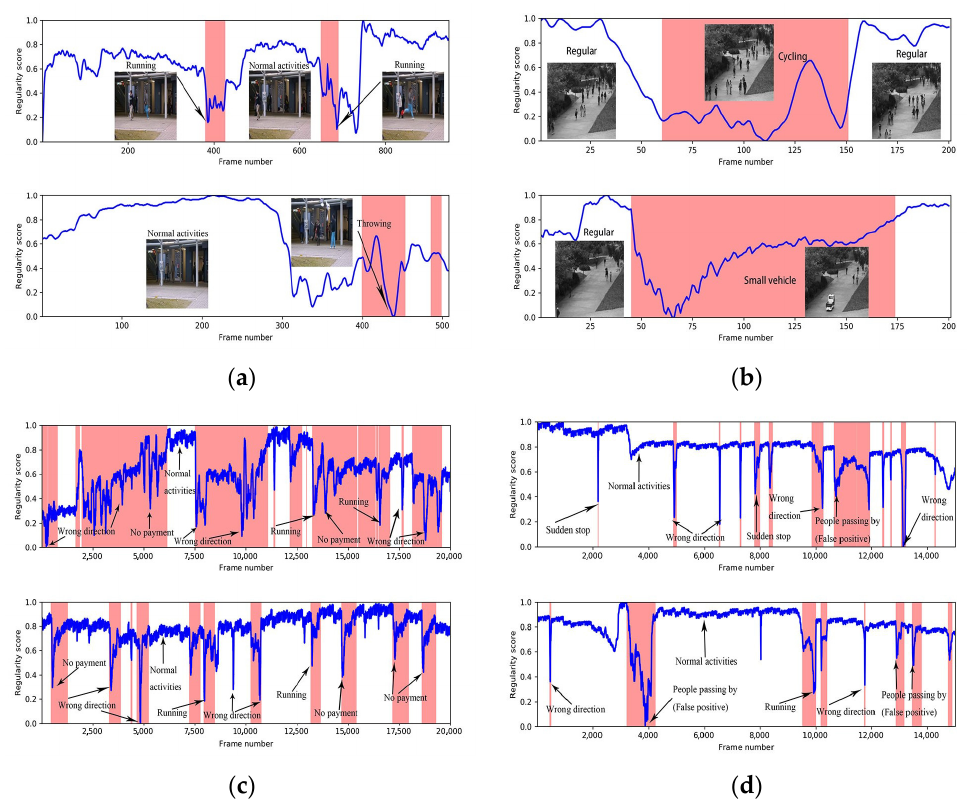
Figure 4. Regularity score in the public datasets. The blue curve depicts the value of the regularity score, while the red shaded regions represent ground truth frames of the abnormal events. When anomalies occur, the regularity score drops significantly. ( a ) Avenue dataset in sequence #01 and #14; ( b ) UCSD Ped1 dataset in sequence #01 and #20; ( c ) Subway Entrance dataset in sequence #01 and #06; and ( d ) Subway Exit dataset in sequence #01 and #03. Table 5. Performance of the object-level detection on various